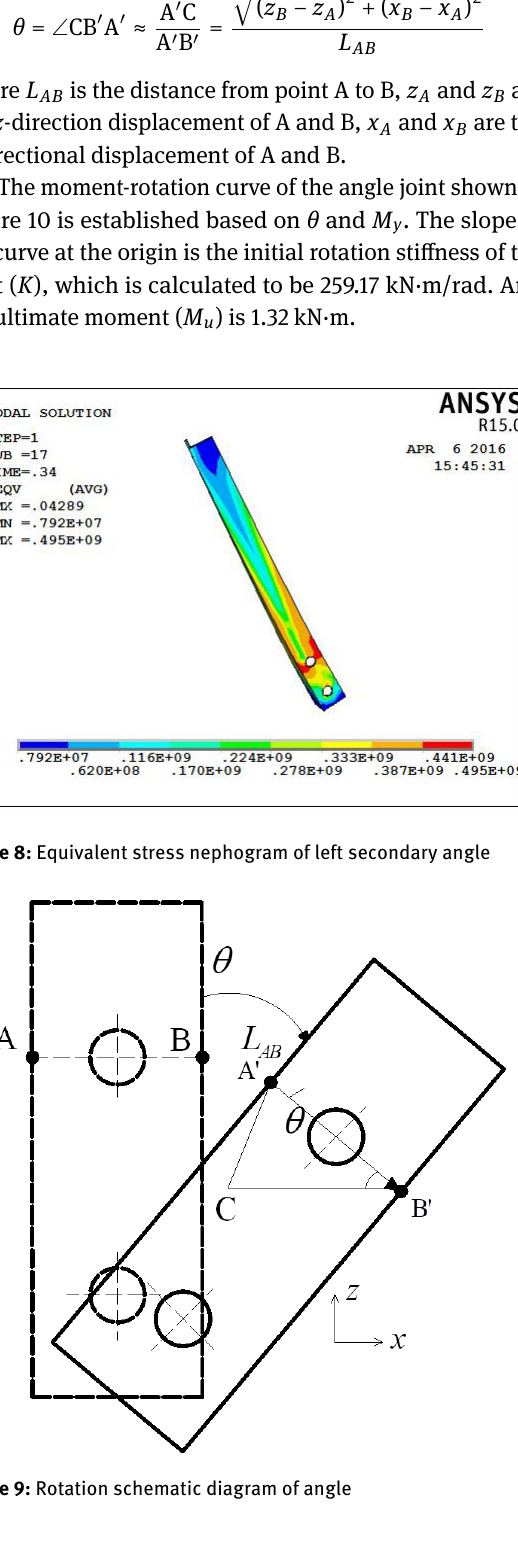
Figure 7: Local deformation of secondary angle (Magnified 10 times)